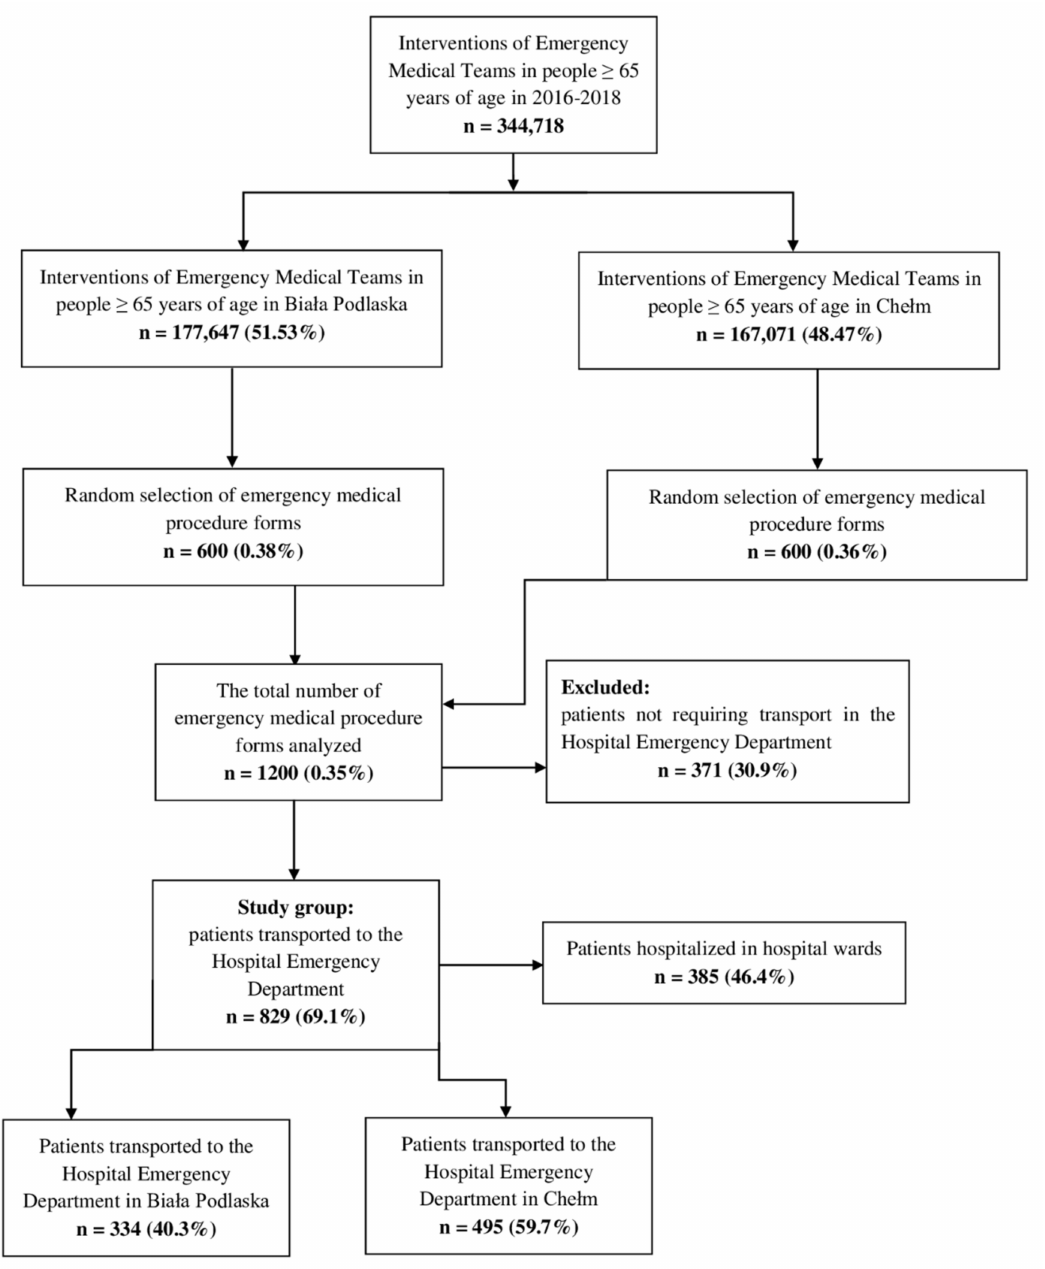
Figure 1. Patient enrolment in the study (a CONSORT